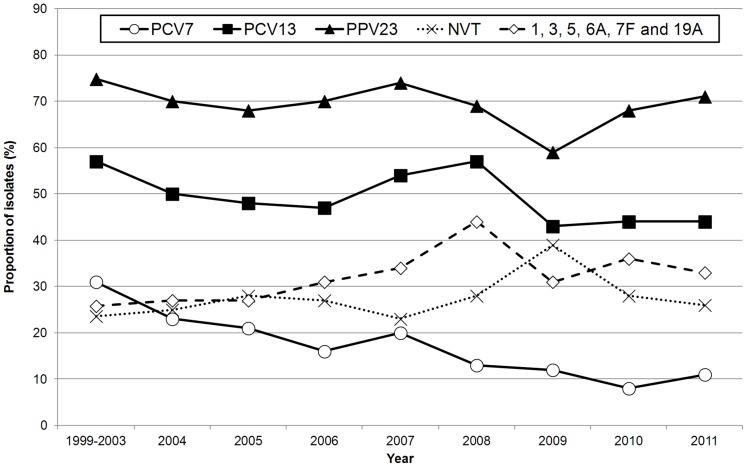
Proportion of isolates expressing serotypes included in pneumococcal vaccines causing non-invasive pneumococcal pneumonia in adults in Portugal (1999–2011).The value shown for 1999–2003 refers to the yearly average of the 500 isolates studied that were isolated in these 5 years. This period was analyzed together since previously published IPD data indicated that these corresponded to a pre-PCV7 serotype distribution [14].